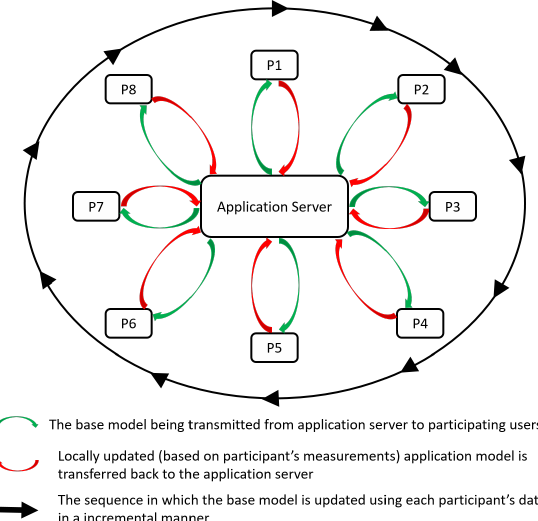
Figure 1: Basic implementation of FL-NoiseMap: Application model being exchanged between the application server and the participat- ing mobile phones in a round-robin